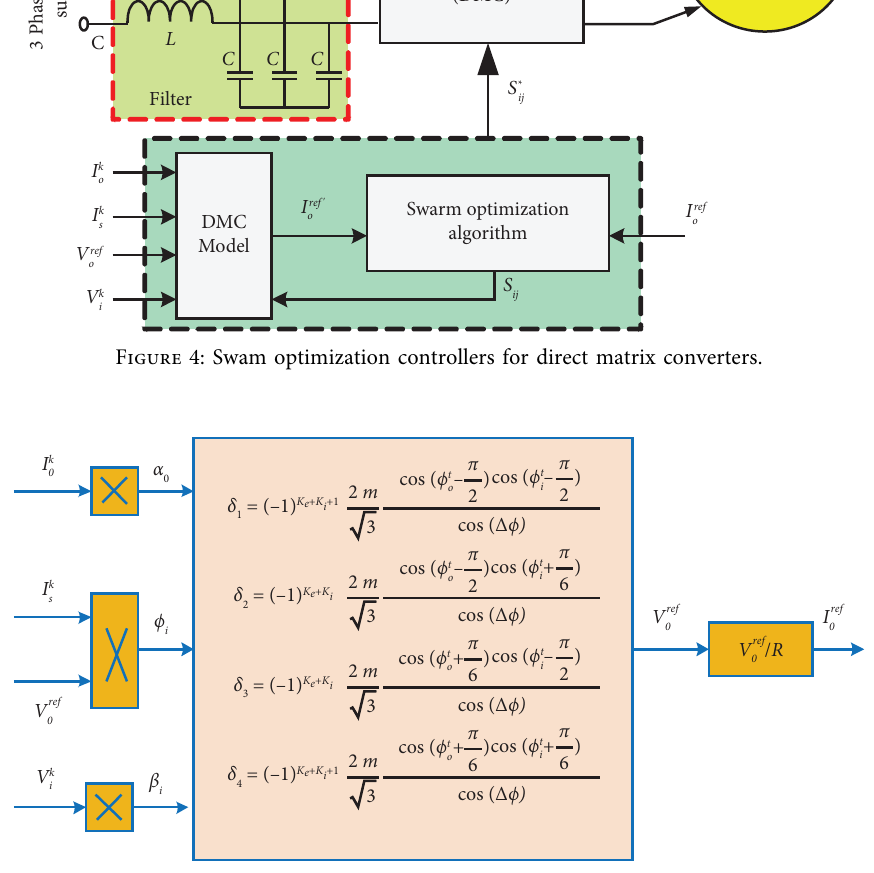
Figure 5: DMC model block diagram with the simple mathematical model. Table 1: Test system